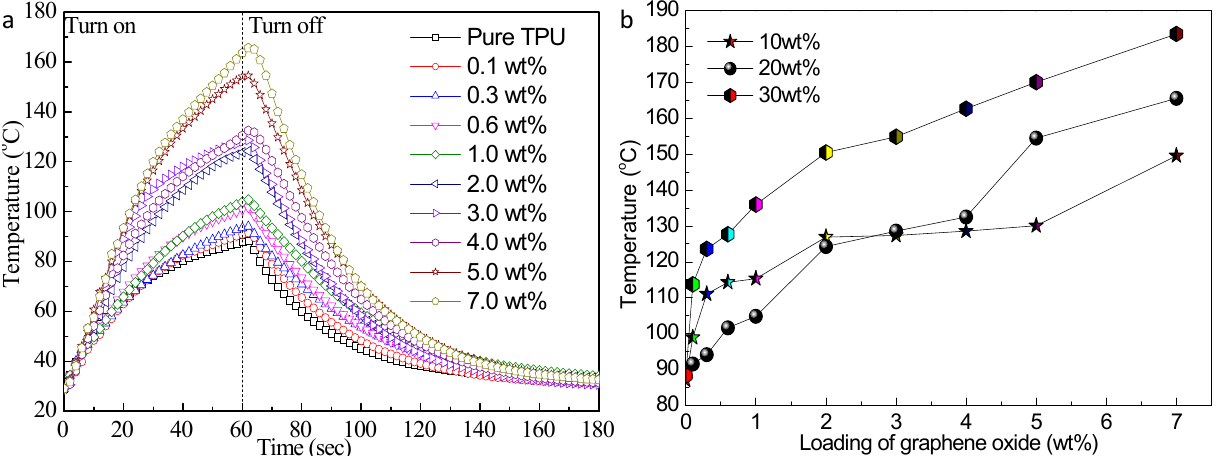
Figure 10. ( a ) Time-dependent temperature of GO-TPU films with the initial concentration of TPU of 20 wt % under near-infrared light with different loadings of GO and ( b ) the maximum conversion temperature with different initial concentrations of TPU of 10 wt %, 20 wt %, and 30 wt %, respectively, and different loadings of GO after 60 s of infrared light irradiation.